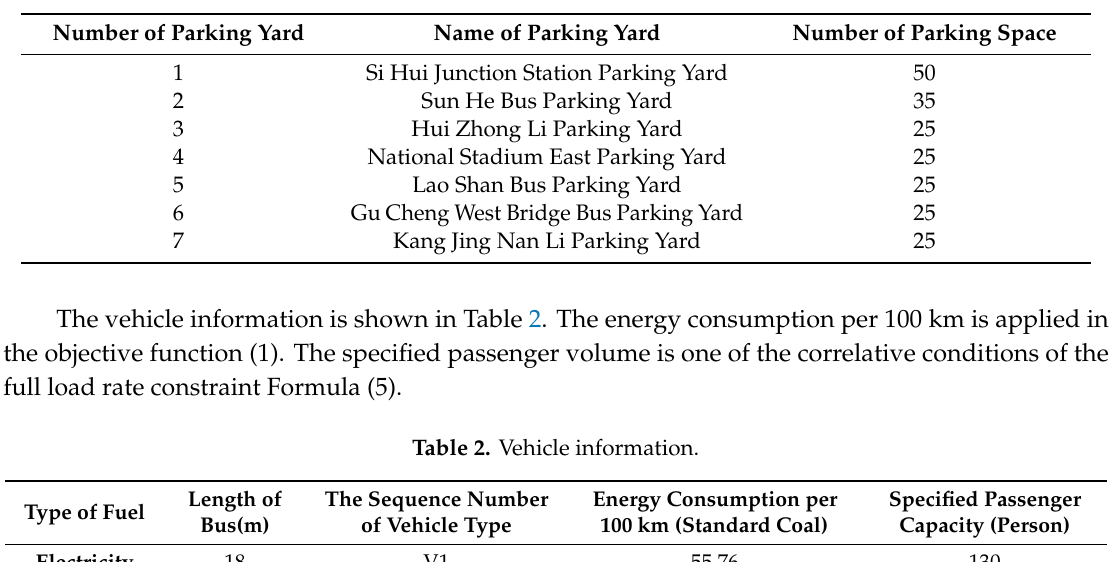
Table 1. Parking yard information.